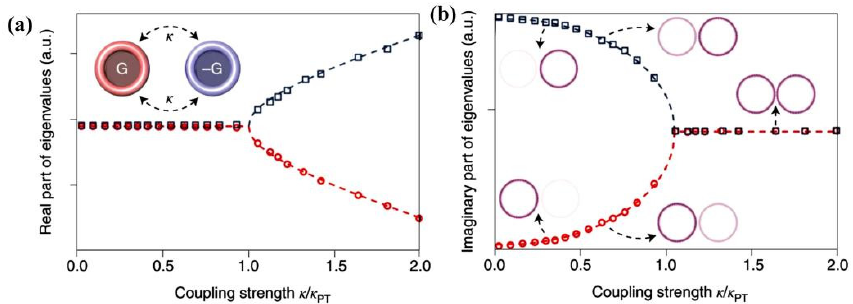
Figure 11. ( a ) The change process of real part of eigenvalue of the system. Adapted with permission from Ref. [155]. ( b ) The change process of imaginary part of eigenvalue of the system.